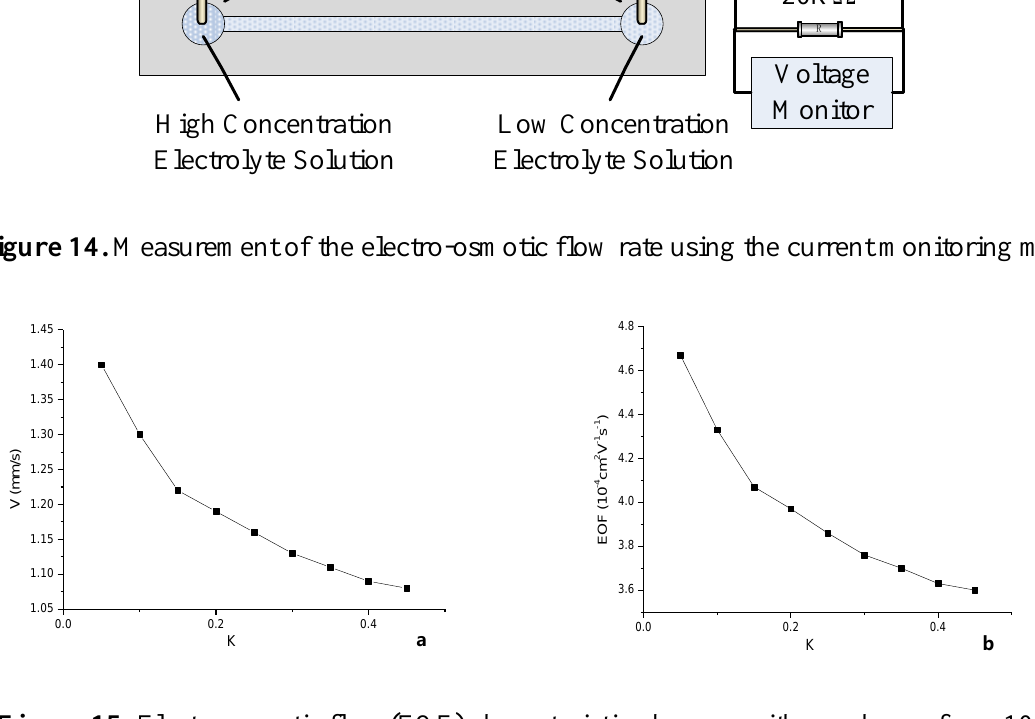
Figure 15. Electro-osmotic flow (EOF) characteristic changes with roughness for a 100 μm microchannel in a 300 V/cm electric field. ( a ) EOF velocity changes with different roughness; ( b ) EOF changes with different